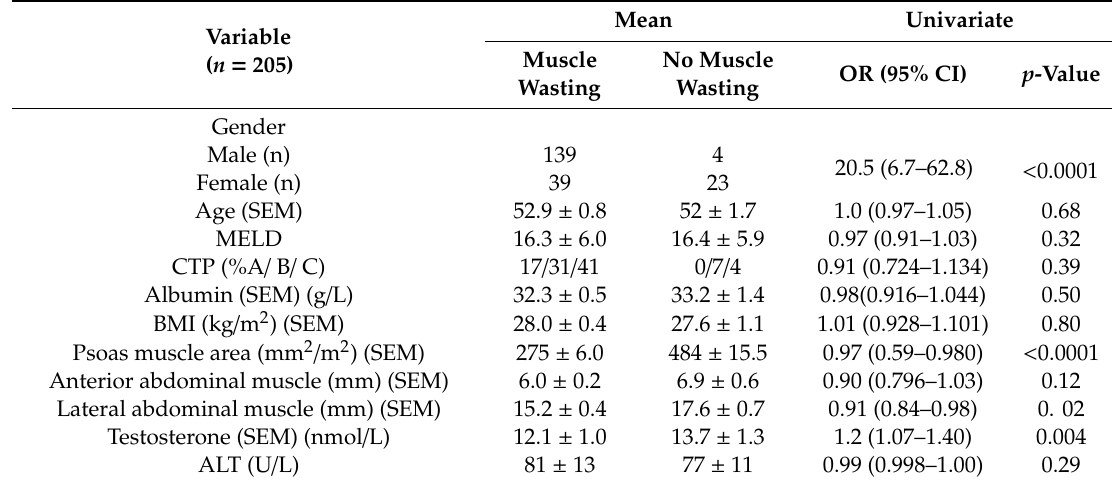
Table 3. Univariate logistic regression analyses of variables as potential predictors of sarcopenia in patients on the liver transplant waiting